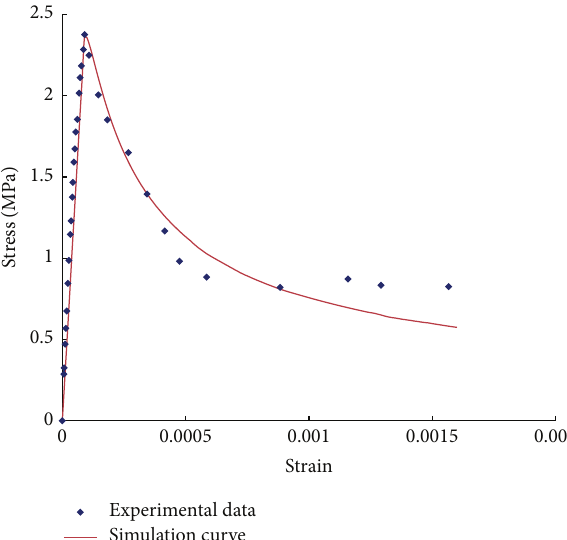
Figure 9: Comparison of stress-strain relationship between numer- ical simulation and experimental tests for specimen A5.